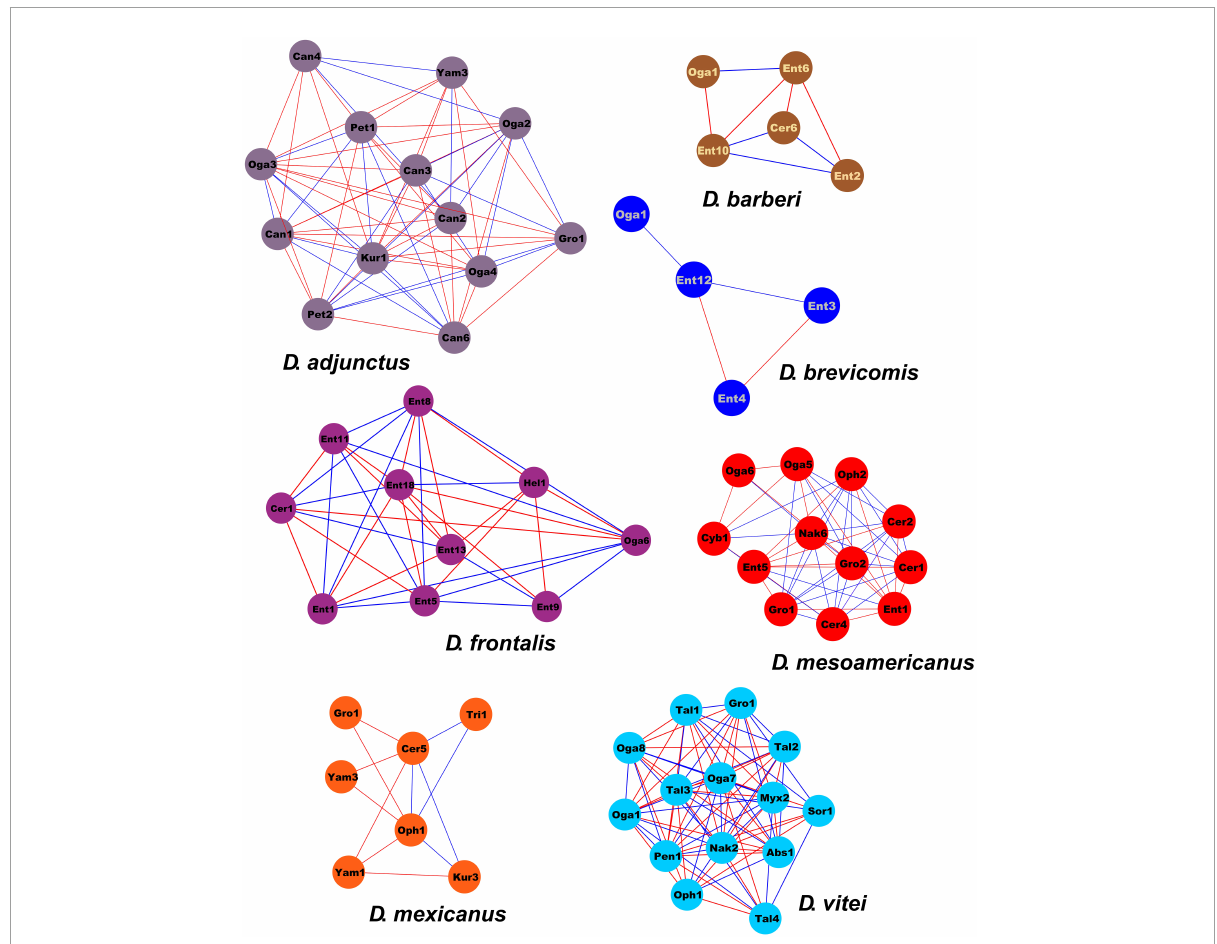
FIGURE5 Individual network extracted from global network of the mycetangial fungi from each species of the D . frontalis complex species. The nodes are colored in each module according to the bark beetle species from which ASVs were identified. Individual networks were integrated by different ASV numbers. Blue lines indicate positive interactions (mutualism or commensalism), while a red lines indicates negative interactions (antagonism). Filamentous Fungi: Abs, Absidia ; Bea, Beauveria; Cer, Ceratocystiopsis; Cld, Cladosporium; Ent, Entomocorticium ; Gro, Grosmannia-Leptographium ; Hel, Helotiales; Myx, Myxotrichum ; Oph, Ophiostoma-Sporothrix ; Pen, Penicillium ; Sor, Sordariomycetes; Tal, Talaromyces ; Tri, Trichoderma. Yeast: Can, Candida ; Cyb, Cyberlindnera ; Kur, Kuraishia ; Nak, Nakazawaea; Oga, Ogataea; Pet, Peterozyma ; Yam, Yamadazyma